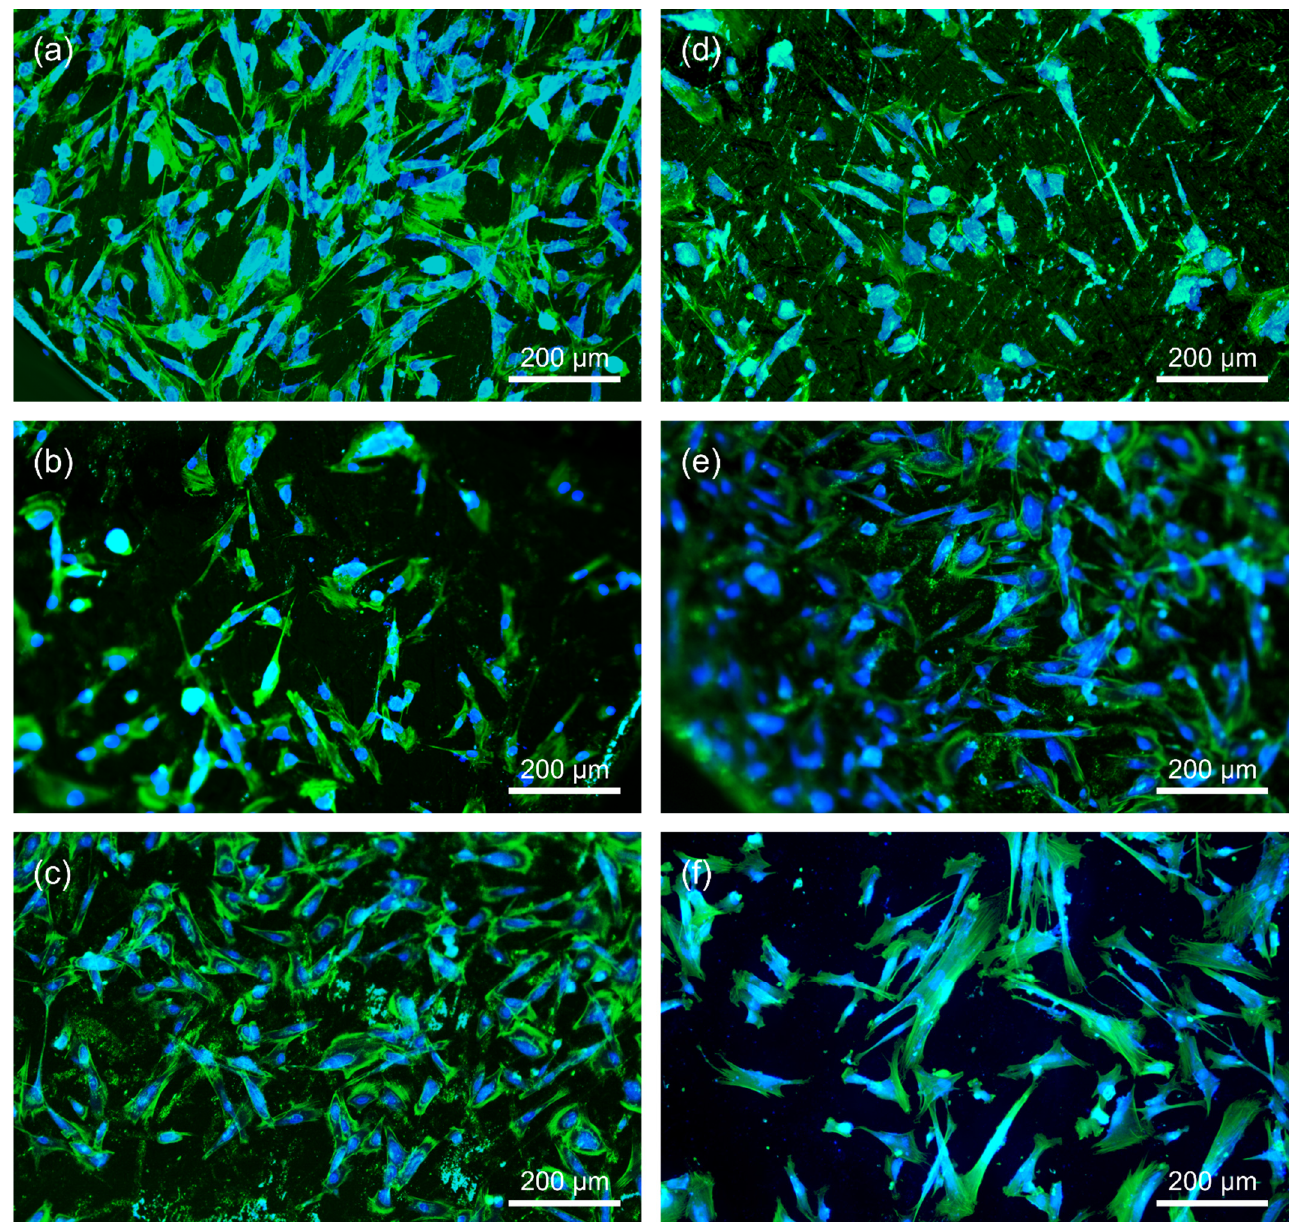
Figure 7. Fluorescence staining of the actin cytoskeleton of fibroblasts (IMR90 cell line) cultured for 24 h on ( a ) Zr 40 Ti 15 Cu 10 Ni 10 Be 25 , ( b ) Zr 50 Ti 5 Cu 10 Ni 10 Be 25 , ( c ) Zr 40 Ti 15 Cu 10 Ni 5 Si 5 Be 25 , ( d ) 316L steel, and ( e ) Ti6Al4V alloy. ( f ) Fibroblasts cultured on glass slides served as a negative control (NC).